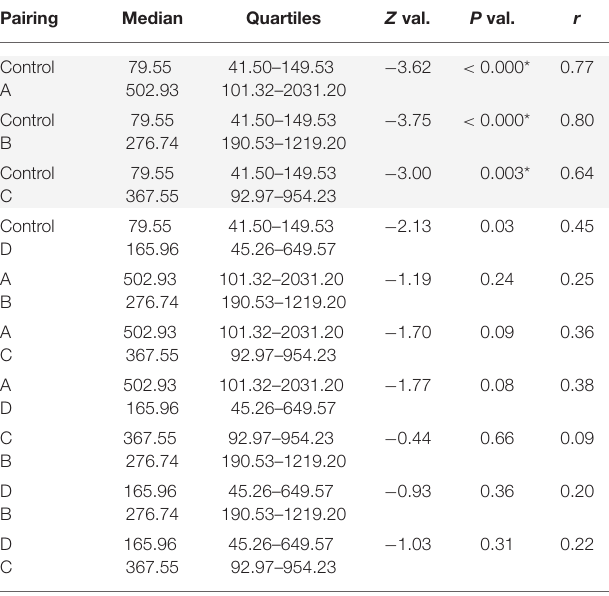
TABLE 2 | Wilcoxon signed-rank test—distance spent following the attractor.